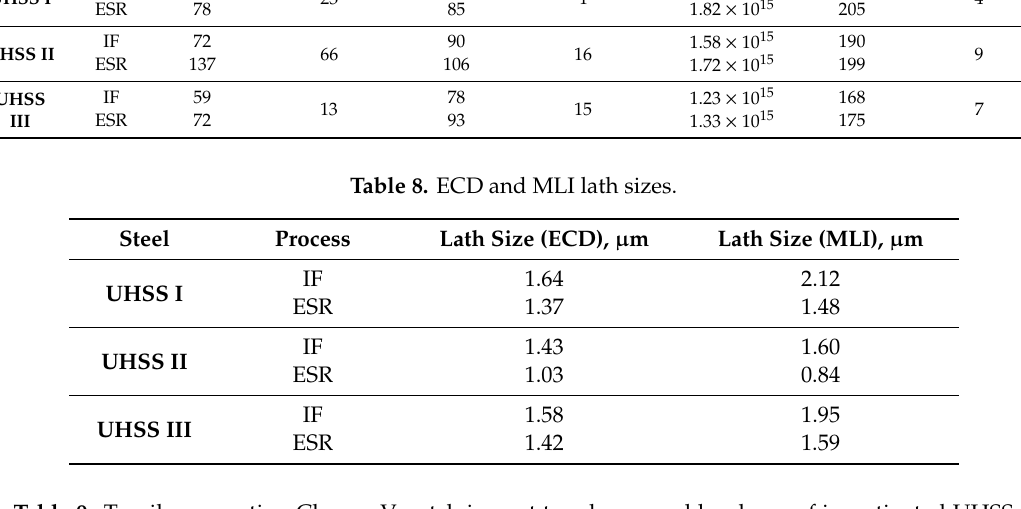
Table 9. Tensile properties, Charpy-V notch impact toughness and hardness of investigated UHSS without and with